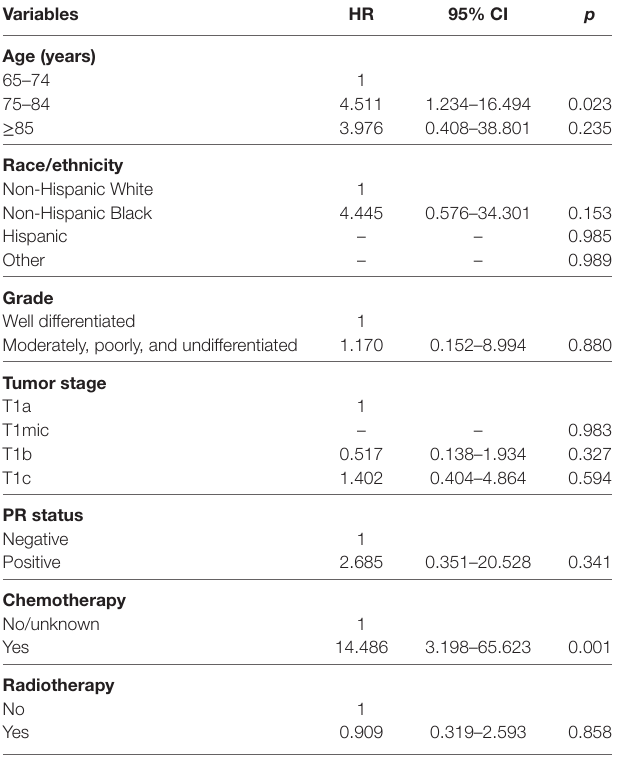
TaBle 4 | Univariate prognostic analyses after propensity score matching.